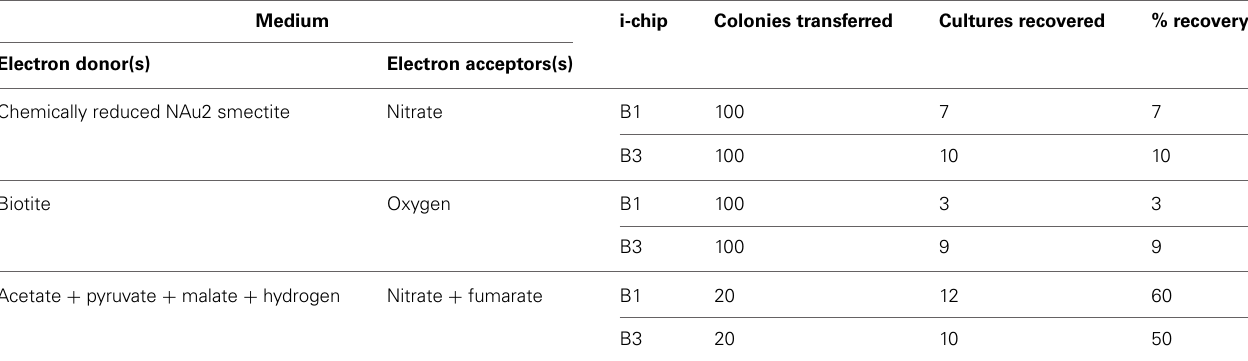
Table 3 | Microbial recovery from i-chips B1 and B3 (see Figure A1) targeting Fe(II)-oxidizing